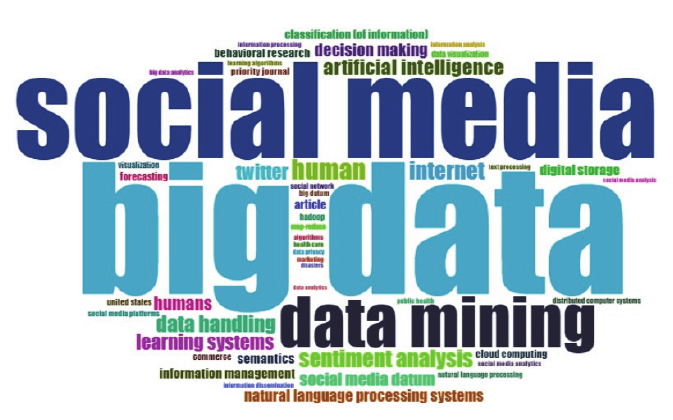
Fig. 3. The frequency of the keywords used in different big data in social